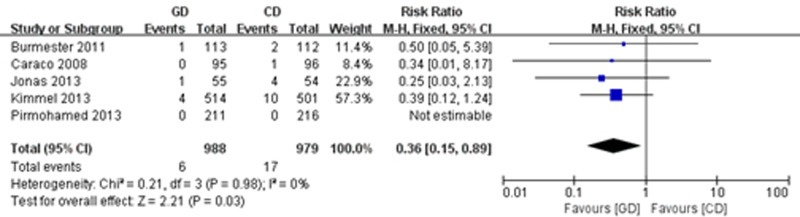
Forest plot of major bleeding.